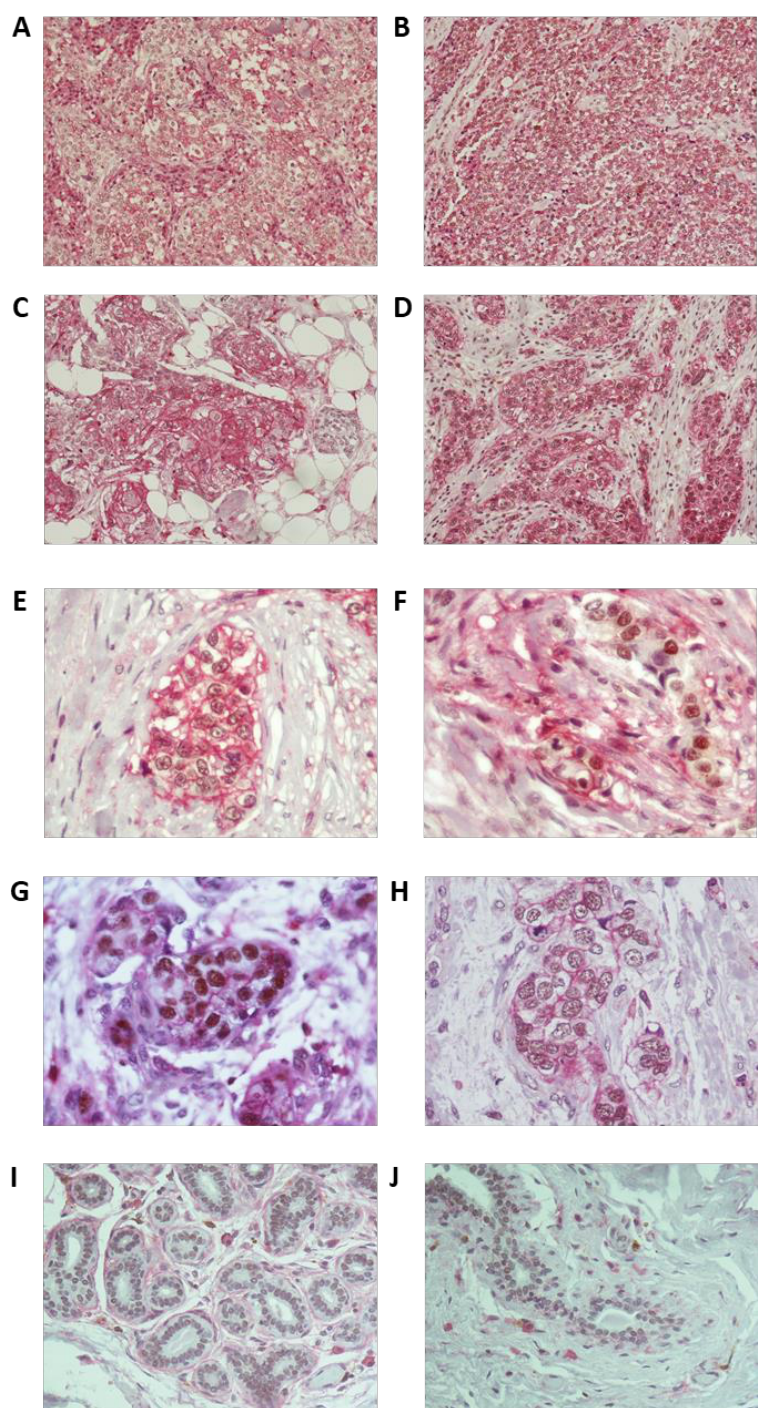
Figure 3. Immunohistochemistry in breast tumor sections from triple-negative breast cancer (TNBC) patients for LSD1 and the stemness marker CD44. ( A – D ) Representative images from four different tumors (cases 4, 8, 9, and 10 in Table S1) showing high enrichment in CD44 + cells and high co-expression of CD44 and LSD1. Magnification 200×. ( E ) Very high ( − 100%) and ( F ) lower ( − 40%) concomitant expression of LSD1 and CD44 in neoplastic cells. ( G ) Strong and ( H ) moderate nuclear staining for LSD1 in neoplastic cells. Magnification 600×. ( I , J ) Non-neoplastic cells of the adjacent breast parenchyma with weak nuclear LSD1 staining from two different tumors (magnification 400×). The cell surface antigen CD44 exhibits membranous staining (chromogenic substrate: magenta) and LSD1 is nuclear (chromogenic substrate: DAB).